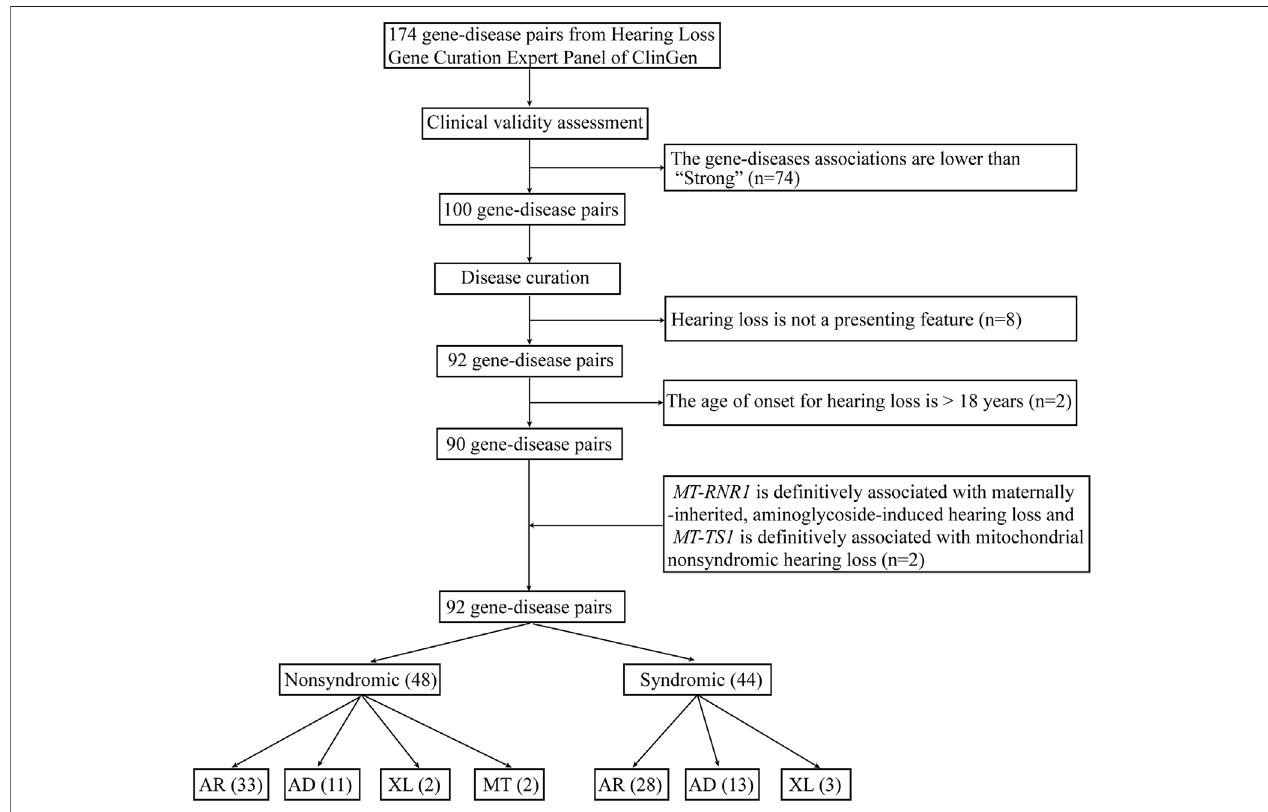
FIGURE 2 | The work fl ow of gene curation for hearing loss. AR, autosomal recessive; AD, autosomal dominant; XL, X-linked; MT,